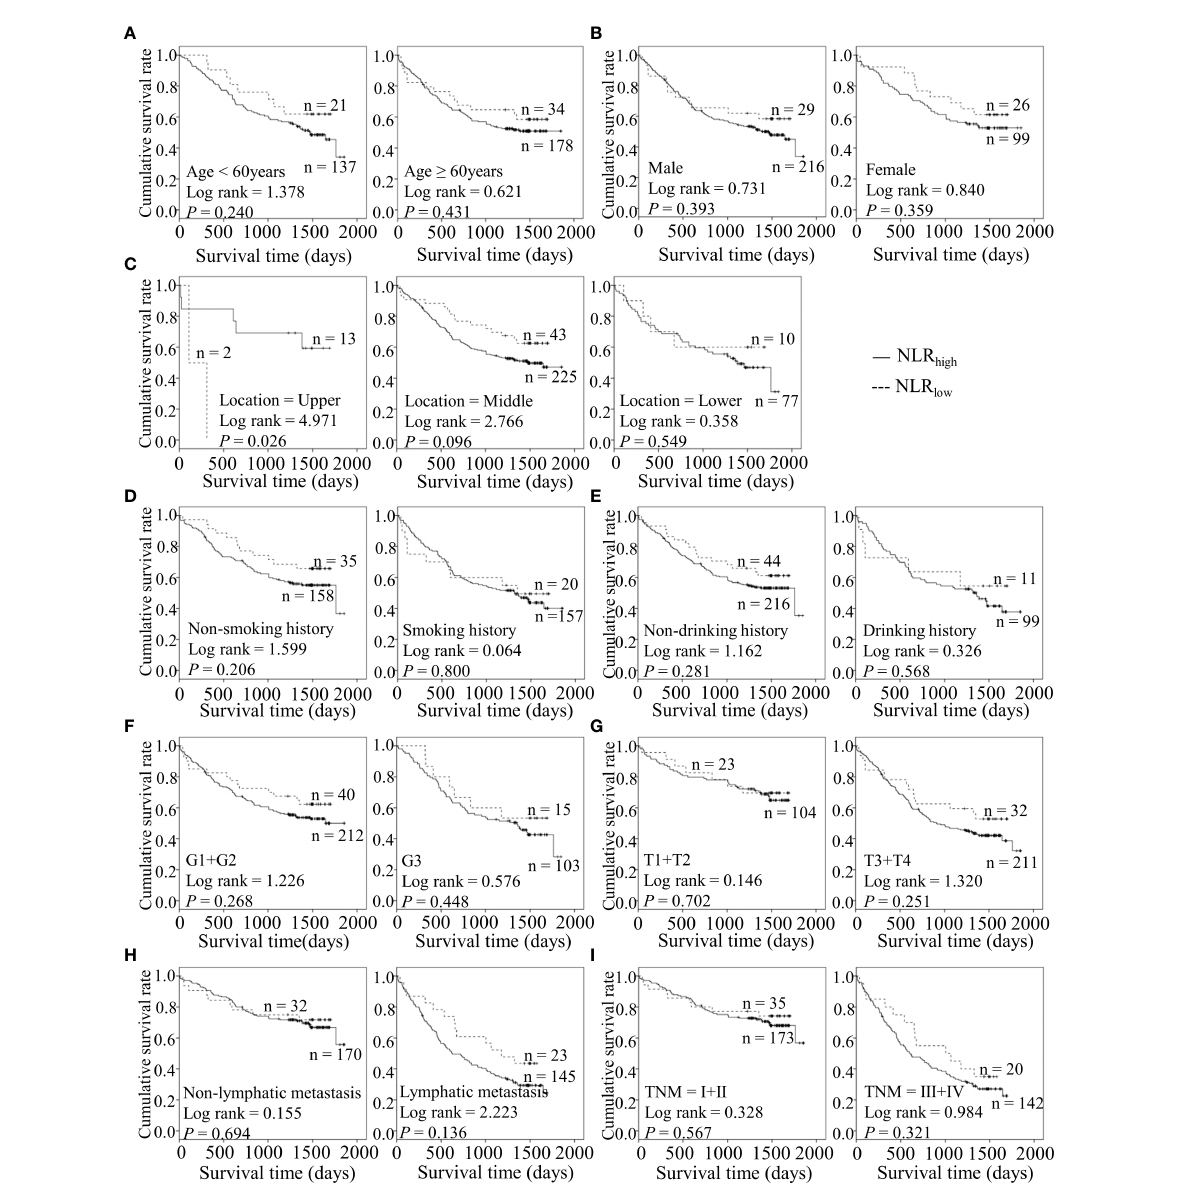
FIGURE 4 Predicating role of preoperative NLR level for the OS of ESCC patients. (A – I) Kaplan-Meier survival curves of ESCC patients with different NLR levels combined with diverse features like age (A) , gender (B) , tumor location (C) , smoking history (D) , drinking history (E) , tumor grade (F) , T stage (G) , lymph node metastasis (H) and TNM staging (I)